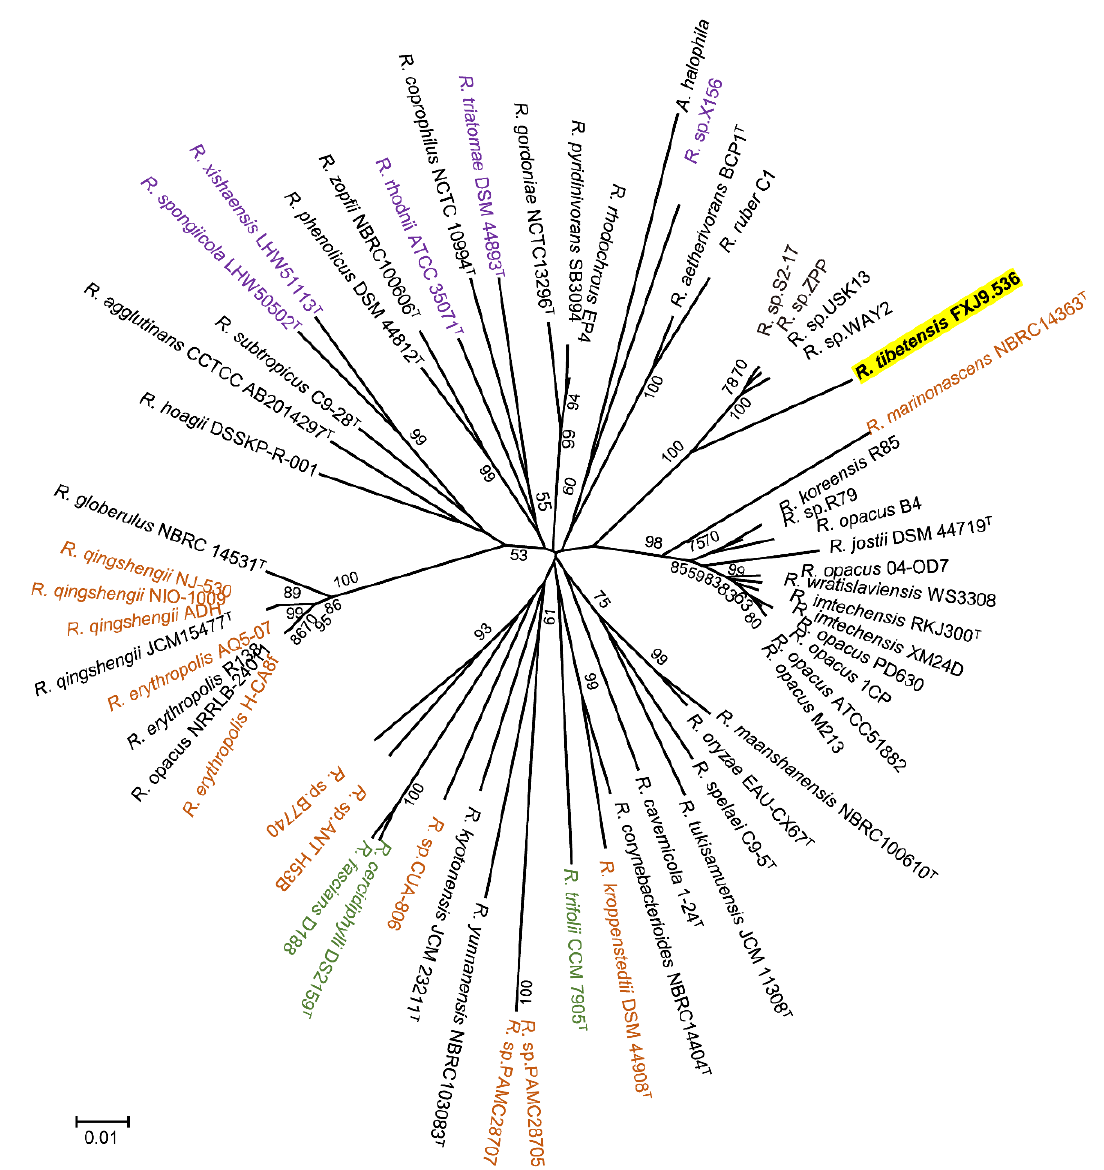
Figure 2. Maximum-likelihood phylogenomic tree generated from concatenated 450 core genes of R. tibetensis FXJ9.536 and 59 related strains of the genus Rhodococcus . A. halophila DSM 43834 T was used as an outgroup. Strains derived from plants, animals, and extreme environments (marine sediments, alpine regions, and polar regions) are highlighted in green, purple, and orange, respectively. Only bootstrap values above 50% are given. Bar, 0.01 substitutions per site.